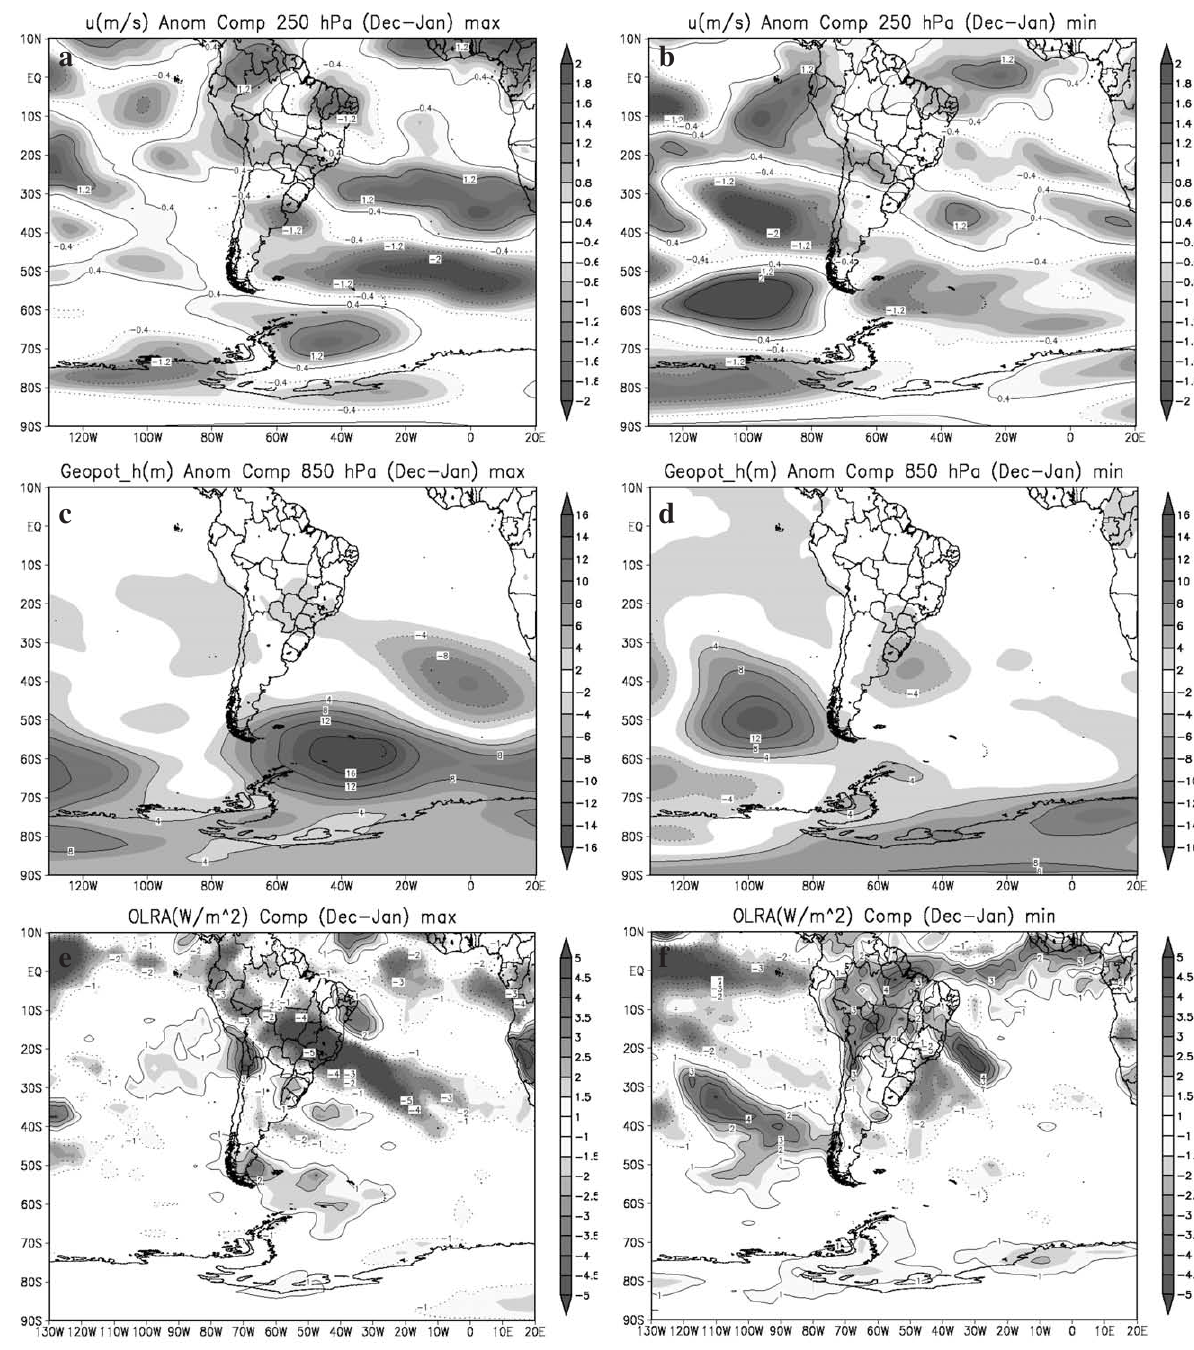
Fig . 6. – Anomaly composite fields of: a) zonal wind at 250 hPa for maximum catch years; b) zonal wind at 250 hPa for minimum catch years; c) geopotential height at 850 hPa for maximum catch years; d) geopotential height at 850 hPa for minimum catch years; e) outgoing long wave radiation for maximum catch years; f) outgoing long wave radiation for minimum catch years. Dashed lines are negative anomaly values and continuous lines are positive anomaly